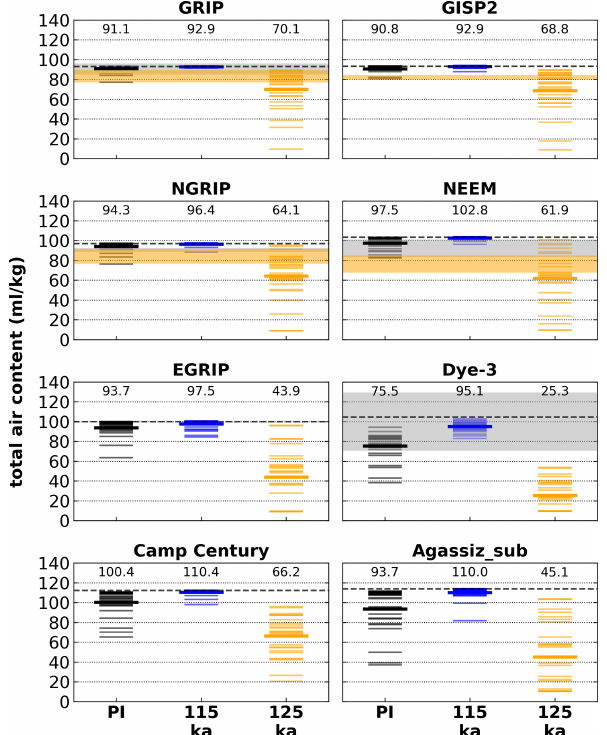
Figure 6. Calculated TAC at Greenland ice core locations derived from simulations with the MAR climate model for three time slices (see method in Sect. 2). Individual model years (thin lines) and the simulation ensemble means (bold lines, numerical values on top of columns) are compared to observed late Holocene and Eemian ranges (horizontal gray and orange shading, respectively; 2 standard deviations). Dashed lines illustrate the model-derived TAC before reducing it by the refreezing percentage (not distinguishable for the respective time slices; see Sect. 2). Note that the Holocene range at NGRIP is very narrow and almost completely overlaps with the Eemian range, and there is no Holocene range for GISP2 and no Eemian range for Dye-3.